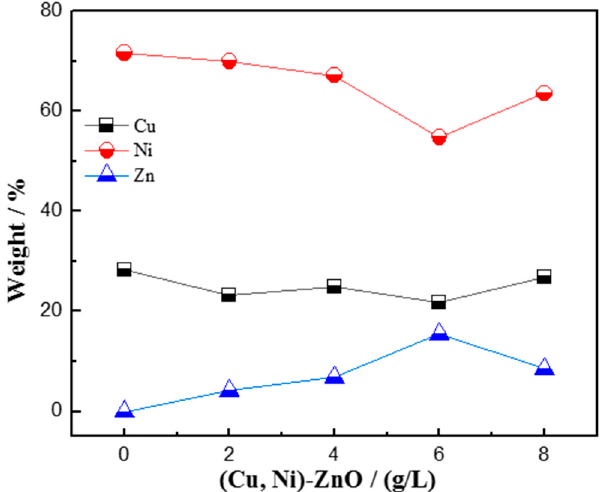
Figure 4. Composition of Cu, Ni, and Zn in Cu-Ni-ZnO nanocomposite coatings with different (Cu, Ni)-ZnO additions.